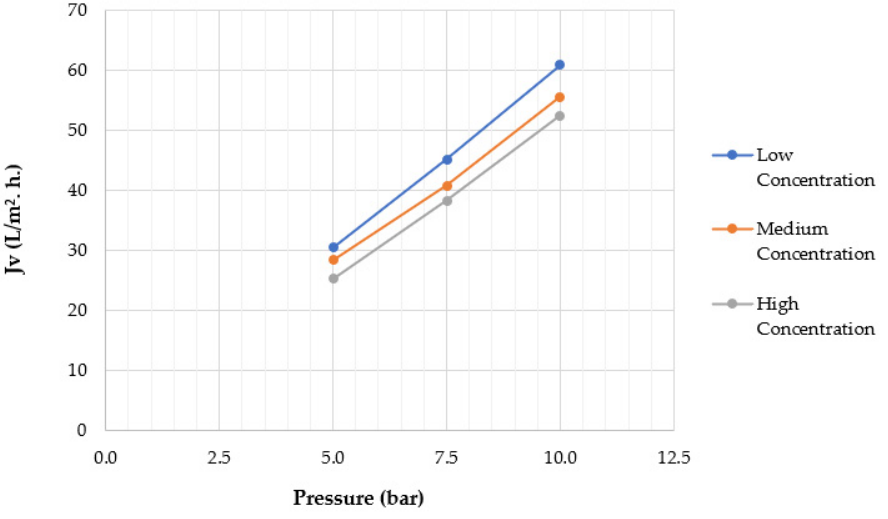
Figure 6. Volumetric flux normalized to 25 ◦ C versus pressure for As solutions (ULP-2540). For pressure variation, centrifugal pumps with capacities of up to 30 bar were used.